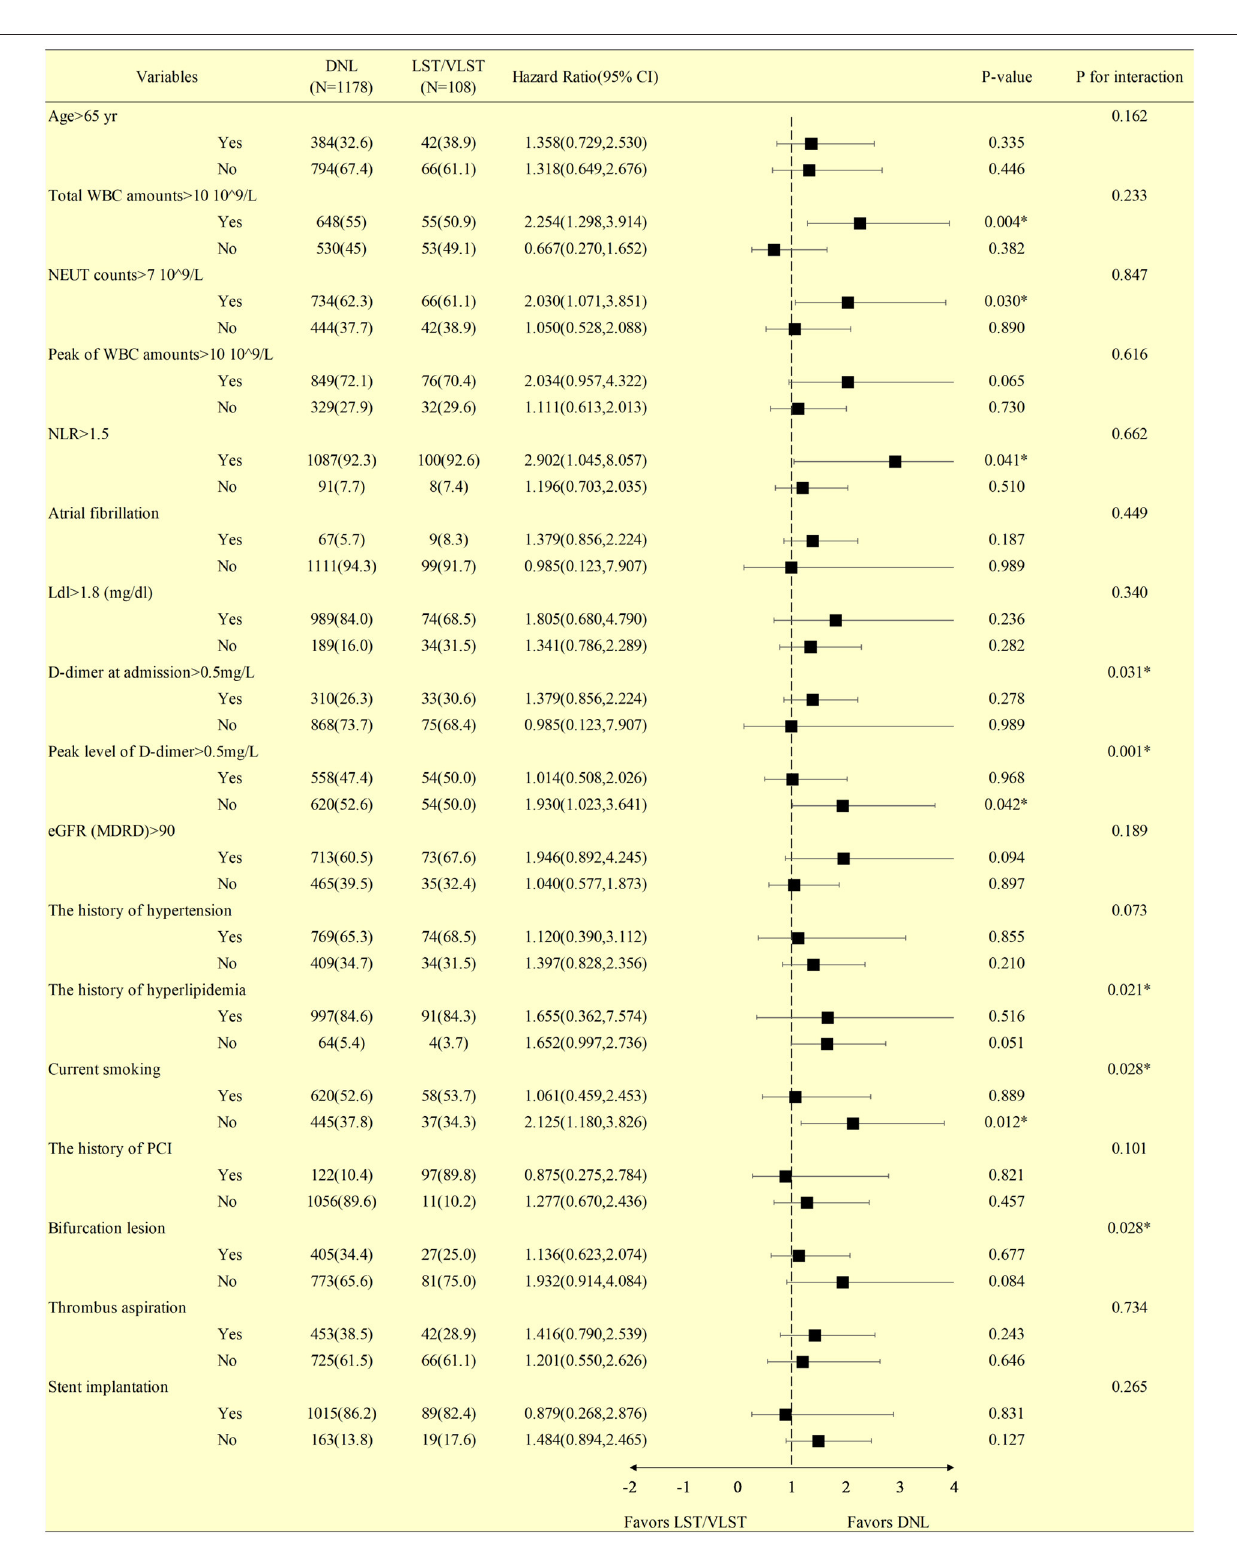
Frontiers in Cardiovascular Medicine |